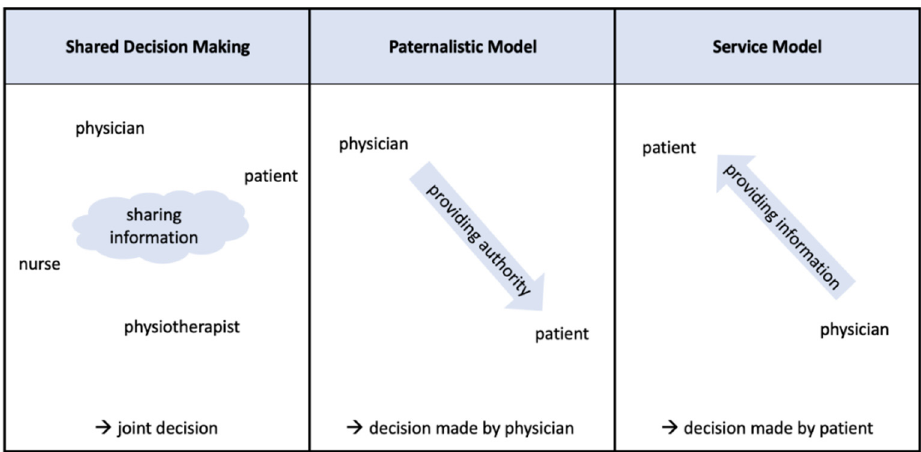
Figure 1. Different models of decision making in